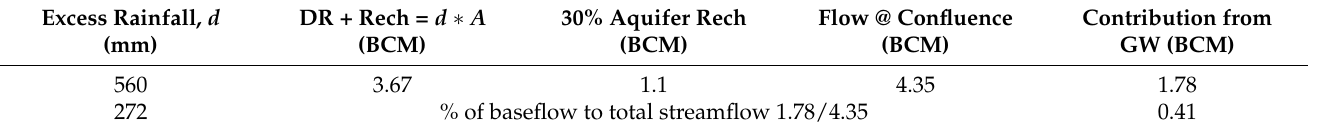
Table 5. Baseflow contribution estimated from precipitation.